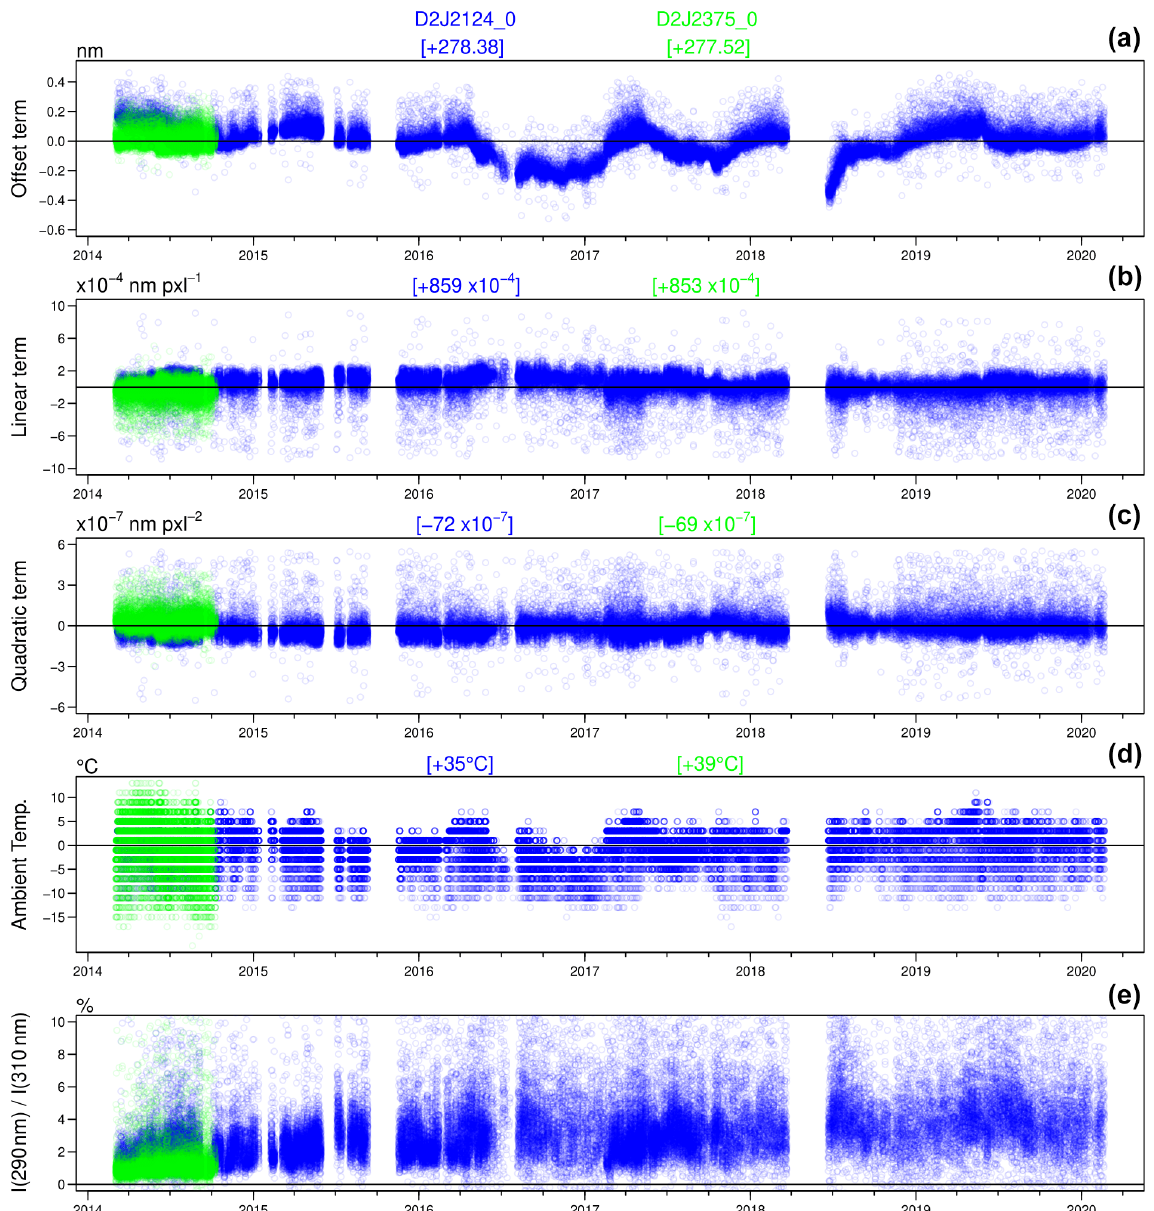
Figure D2. Variation of the instruments’ wavelength-to-pixel calibration and stray light and the ambient temperature. For each parameter, the total values are given by the rough estimate for the mean value (given for each instrument in blue and green above the particular panel) and the variation shown in the plots. The zero lines are chosen arbitrarily and should not be confused with mean values. (a–c) All spectra were calibrated by matching their Fraunhofer lines with the Fraunhofer lines of a solar atlas, and wavelength calibration was given by a calibration polynomial of second order (see e.g. Dinger, 2019, for details). The three panels give for each scan the three coefficients of the wavelength calibration polynomial. The variability is already as displayed rather low but is actually much lower (most of the indicated scatter is predominantly caused by the first scans in the morning when the temperature is significantly lower than for the rest of the day). (d) Variation of the ambient temperature. (e) Ratio of the intensity at around 290 and 310nm (each time average over 10 channels) as a proxy for the magnitude and variation of the stray